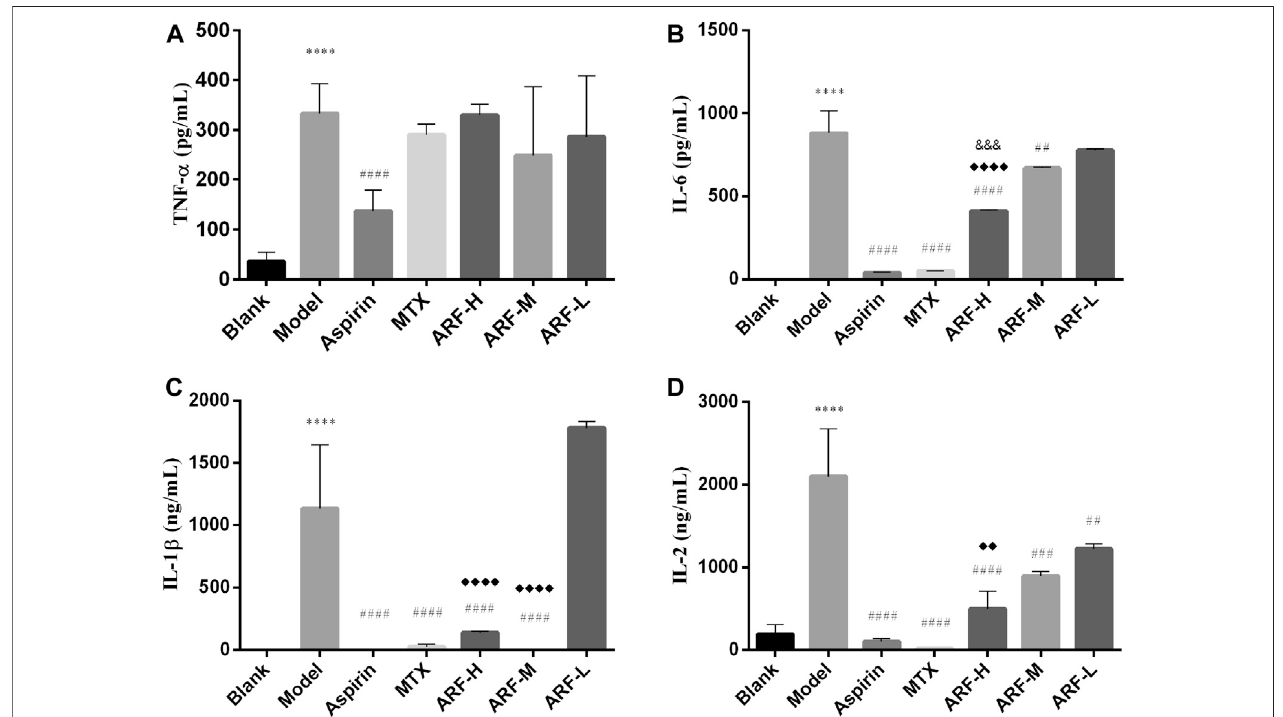
FIGURE5| RegulationofARFonlevelsofIL-6,TNF- α ,IL-1,andIL-2inAIAmodelratsafter21 daysoftreatment. (A – D) LevelsofTNF- α ,IL-6,IL-1 β ,andIL-2inthe plasma, respectively. **** p < 0.001 vs. Blank group. Comparison with the Model group, ## p < 0.01, ## p < 0.005, #### p < 0.001. ◆◆ p < 0.01, ◆◆◆◆ p < 0.001, compared with the ARF-L group. ARF-H group vs. ARF-M group, &&& p < 0.005 is considered signi fi cant. Data are expressed as mean ± SD ( n (cid:1) 8).